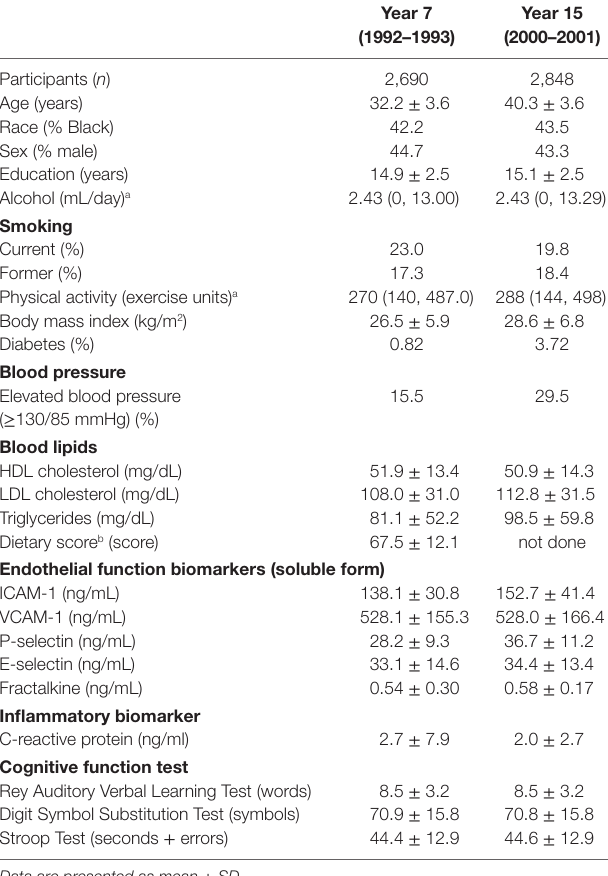
Table 1 | Participant characteristics with circulating biomarkers measurements of endothelial function in 1992–1993 and in 2000–2001, and with cognitive measurement in 2010–2011: coronary artery risk Development in Young adults.